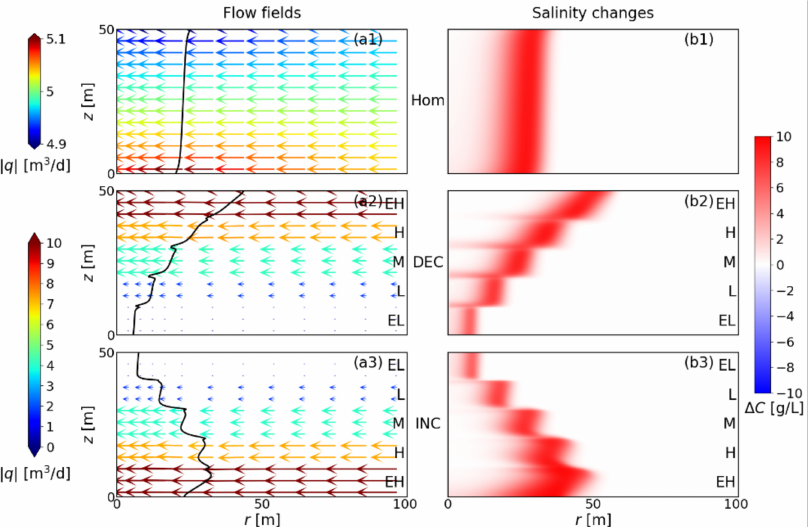
Figure 4. Flow vectors at the intermediate recovery phase (i.e., after 50 days of storage; a1 – a3 ) and the salinity changes during storage (i.e., the difference between the concentration distribution at the end of the recovery phase and that at the start; b1 – b3 ) for the first ASR cycle. Results shown are for the homogeneous anisotropic case ‘Hom’ (top), and the heterogeneous cases ‘DEC’ (middle) and ‘INC’ (bottom). The black lines represent the contour of C = 5 g/L, indicating the approximate location of the fresh-saline